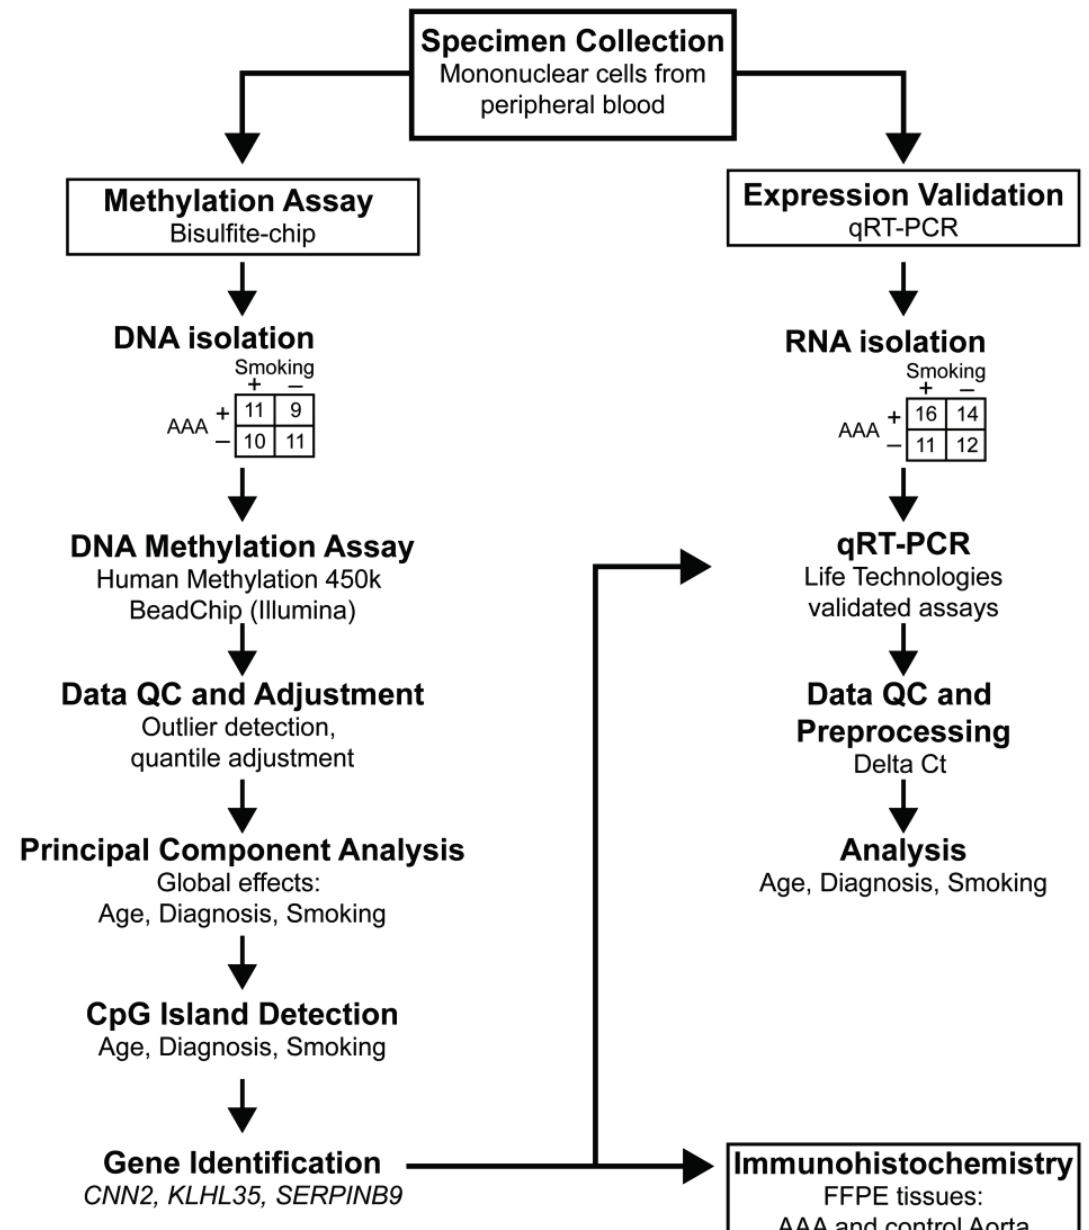
Figure 1. Outline of the study. We collected blood samples and isolated mononuclear cells for DNA and RNA extraction from four all male groups: AAA smokers, AAA non-smokers, control smokers and control non-smokers. Methylation data were obtained using the Illumina 450k HumanMethylation Bead Chip [26] and analyzed using the R language and multiple Bioconductor packages. Principal component analysis and linear analysis of CpG island subsets identified four regions with significant differences in methylation with respect to AAA: kelch-like family member 35 ( KLHL35 ), calponin 2 ( CNN2 ), serpin peptidase inhibitor clade B (ovalbumin) member 9 ( SERPINB9 ), and adenylate cyclase 10 pseudogene 1 ( ADCY10P1 ) (pseudogene). Follow-up studies included RT-PCR and immunostaining for CNN2 and SERPINB9 . Symbols: AAA, abdominal aortic aneurysm; FFPE, formalin-fixed paraffin-embedded tissue; QC, quality